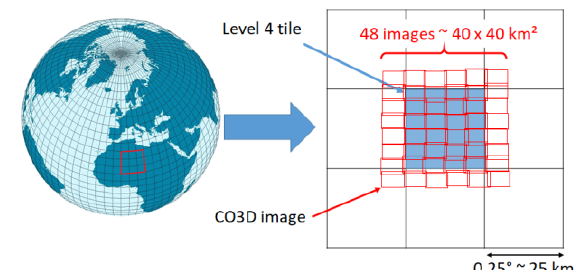
Figure 12. GLOBAL-DEM tiles production strategy